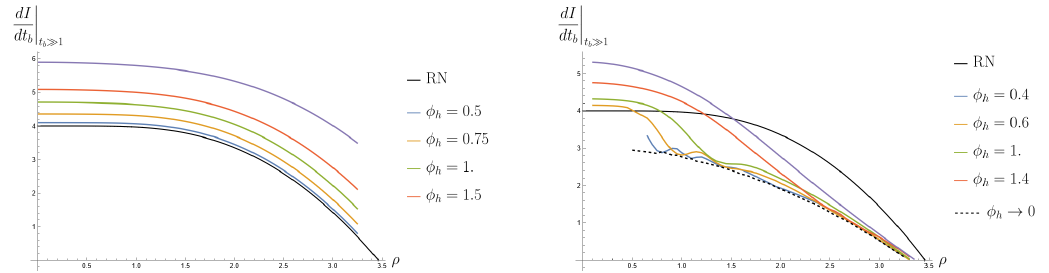
Figure 23 . Asymptotic complexity rate W A as function of ρ for a few values of φ h , with 16 πG = 1 , V 0 = 1 and z h = 1 . For comparison, in black we show W A for the RN black hole. Left: neutral scalar case. In this case W A approaches the RN limit for φ h → 0 . Right: charged scalar case with q = 1 . In this case W A approaches TS , which is shown in the dashed line, in the φ h → 0 limit.